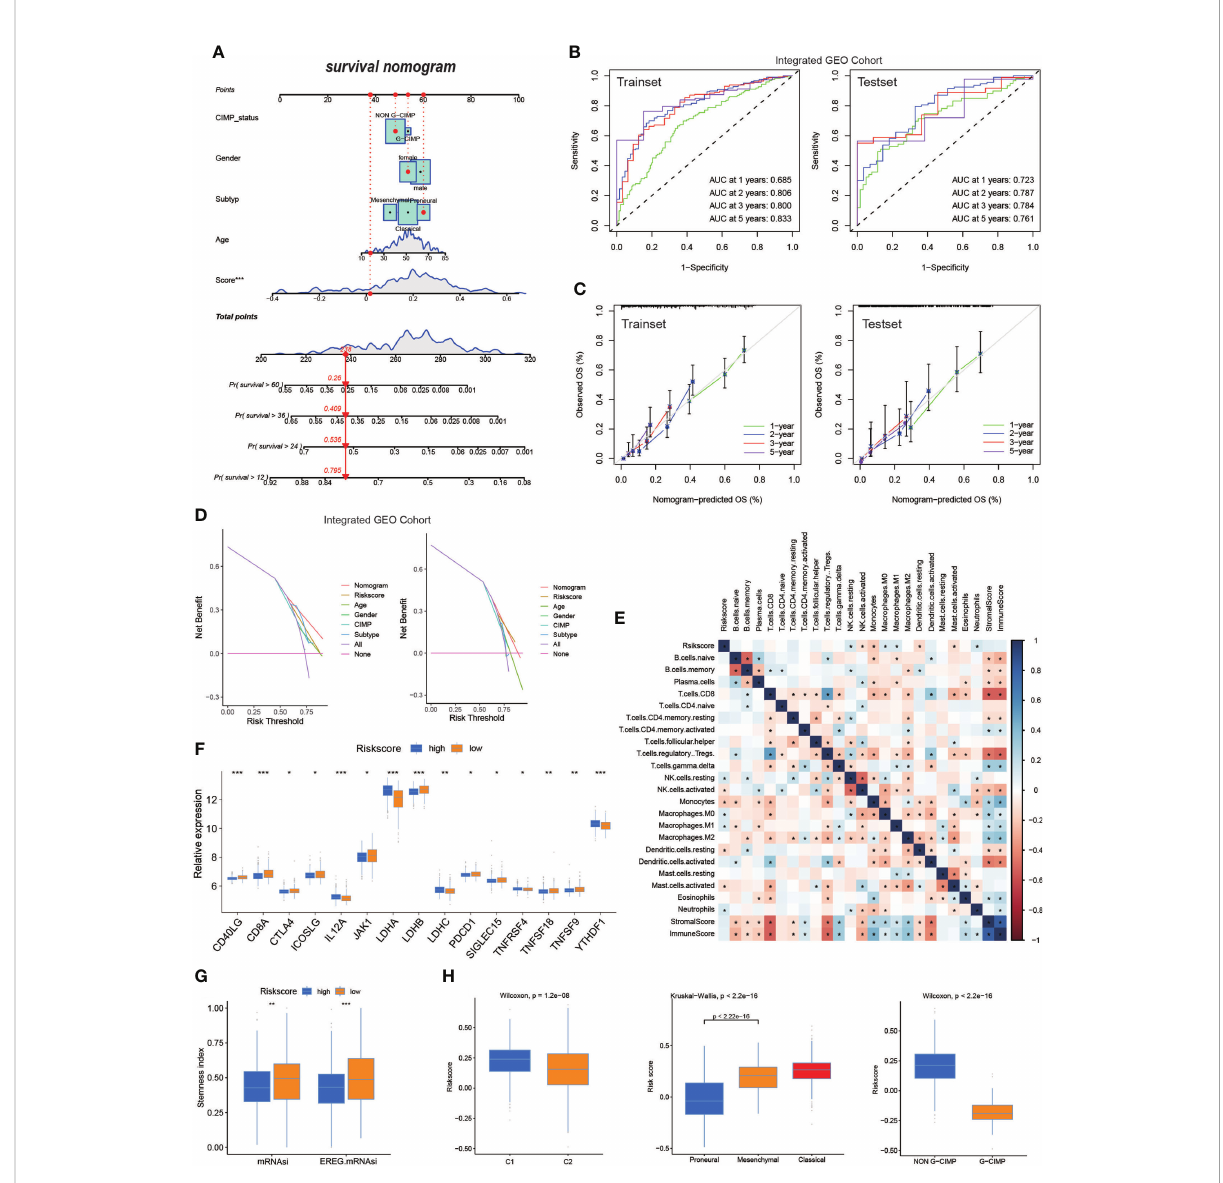
FIGURE 5 The nomogram based on risk score in GBM. (A) Nomogram integrated the age, gender, CIMP_status, subtype, and risk score. (B) The ROC of the train set and the test set containing nomogram. (C) Validation of the ROC of the train set and the test set containing nomogram. (D) The decision curve analysis (DCA) of the train set and the test set containing nomogram. (E) The correlation of risk score and TME in fi ltration cells. (F) Expression of immune checkpoints among high – and low – GBM risk groups. (G) The stemness index difference of high- and low-risk score groups. (H) The relationship between the risk score model and two clusters, GBM subtypes, and G-CIMP subtypes. (*p-value < 0.05; **p-value < 0.01; ***p-value <